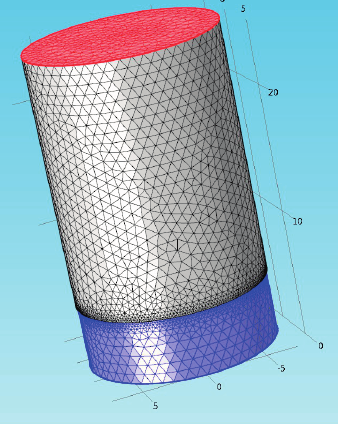
Figure 1. X-ray tube divided into finite elements for electric field calculations. Red and blue parts are anode and cathode,